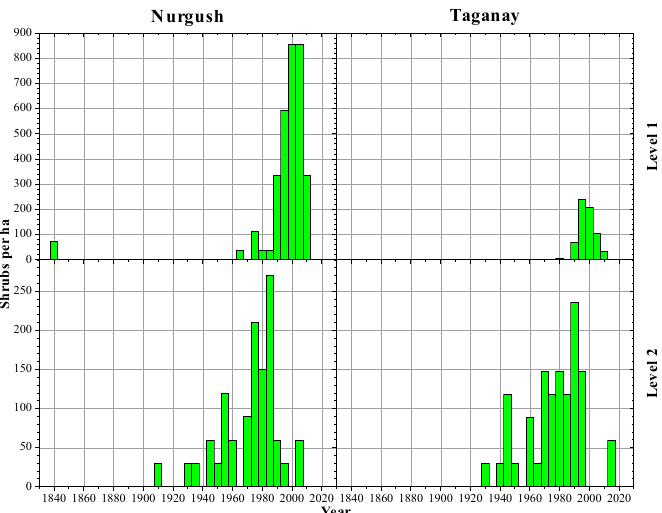
Figure 7. Age structures of J. sibirica on Nurgush and Taganay, Southern Urals. Levels 1 and 2 correspond to high and mid elevations, respectively. In Iremel, recruitment peaked in the 1920s and 1950s at low and high elevations, re- spectively (Figure 8). The oldest J. sibirica shrubs were recruited in the mid-19th century and in the high elevation plots. In Zigalga, the first recruited J. sibirica individuals were dated from the early 19th century and were located at low elevation (Figure 8). Recruit- ment intensified in the 1960s at high elevations in this site. Figure 8. Age structures of J. sibirica on Iremel and Zigalga, Southern Urals. Levels 1 and 2 corre- spond to high and mid elevations, respectively.